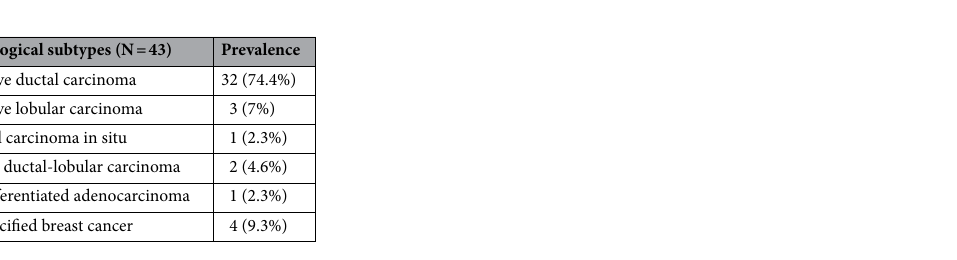
Table 4. Histological classification in patients with breast cancer and pseudocirrhosis reported in case report and case series.